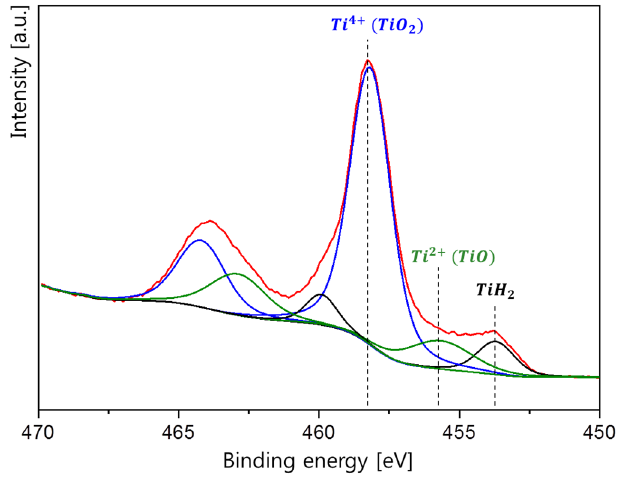
Figure 4. Surface analysis of the ball-milled TiH 2 powders by XPS.